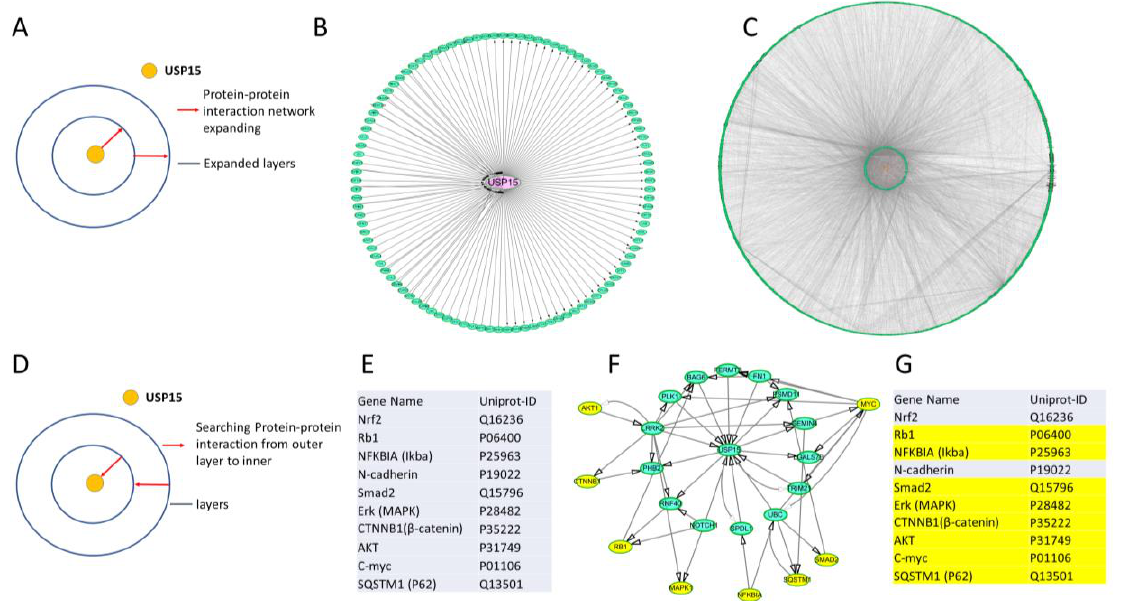
Figure 3. Human USP15 PPI network, a network of proteins that interact directly or indirectly with USP15. The role of eight experimentally accessible proteins. ( A ) Layer 1 proteins interact with USP15, and layer 2 proteins interact with the layer 1 proteins. ( B ) Visualization (circle layout, Cytoscape) of interactions of 105 proteins of layer 1 (outer circle) with USP15 (center node). ( C ) Visualization (circle layout, Cytoscape) of indirect interaction of 6175 proteins of layer 2 (outer circle) with USP15 (center). ( D ) Proteins of layer 2 are linked to USP15 via a protein of layer 1 (inner circle). ( E ) Choice of ten proteins that are tumor-related and experimentally accessible. ( F ) Visualization (circle layout, Cytoscape) of indirect interaction of eight preselected proteins (highlighted in yellow, outer circle) with USP15 (center node). ( G ) Two of the ten preselected proteins were not members of the Human USP15 PPI network (not highlighted in yellow).